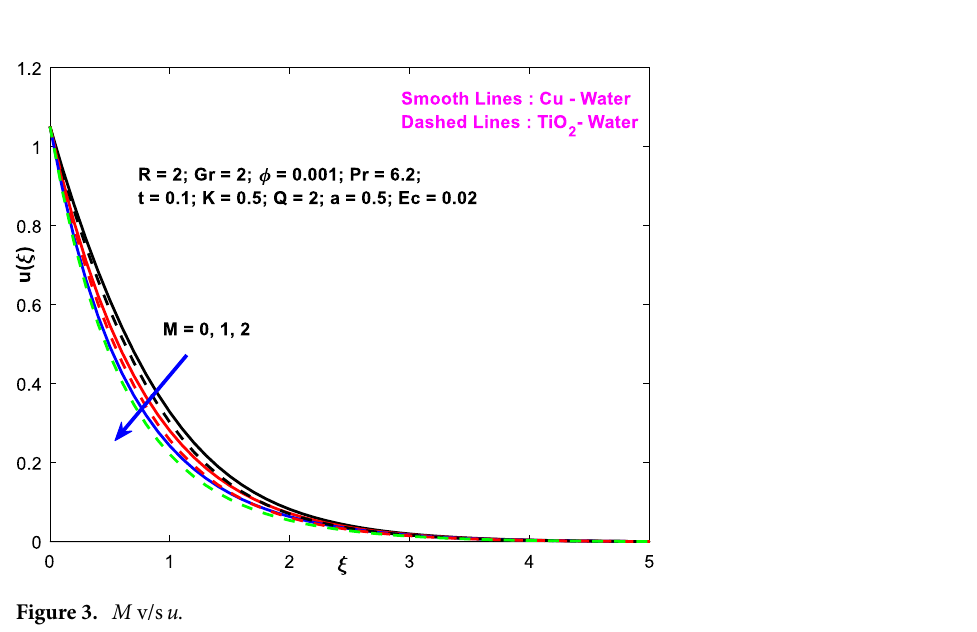
Figure 3. M v/s u